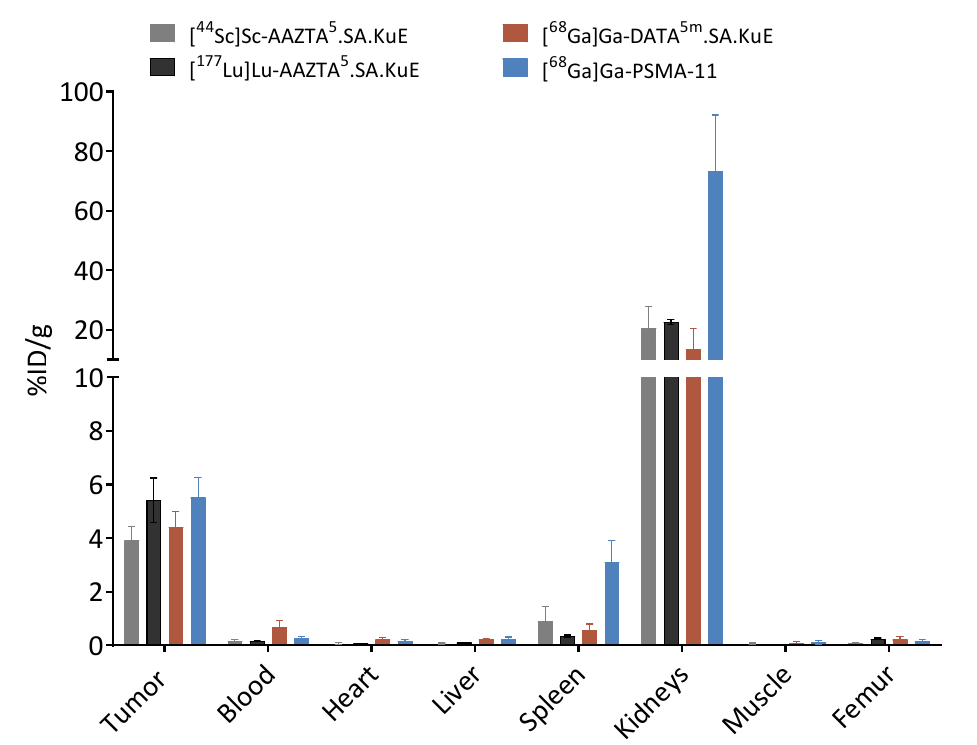
erence; % injected dose per 10 6 LNCaP cells.